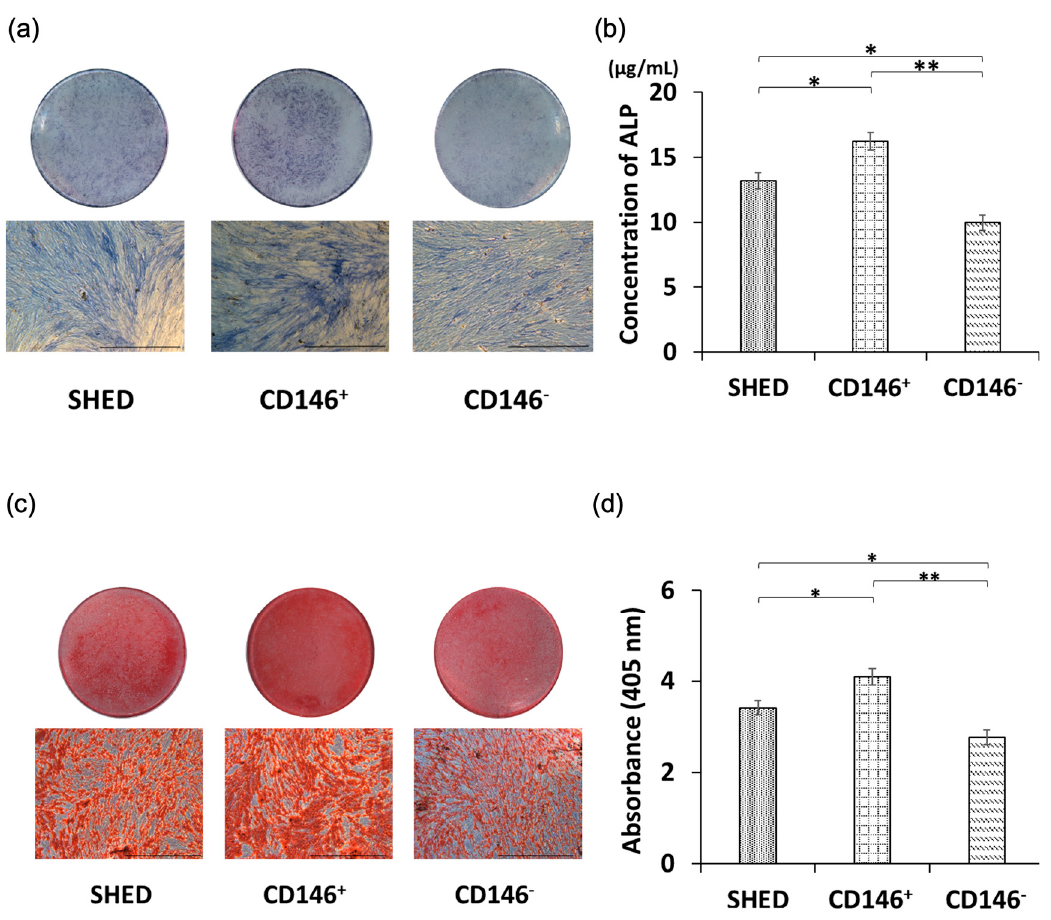
Figure 3. Osteogenic differentiation potential of SHED, CD146 + SHED, and CD146-SHED. ( a ) Osteogenic differentiation assessed by ALP staining on day 21. ALP staining was confirmed in all cells. The ALP staining intensity decreased in the following order: CD146 + SHED, SHED, and CD146- SHED (Scale bar = 500 μ m). ( b ) Determination of ALP protein levels by ELISA. ALP protein levels were significantly higher in CD146 + SHED than those in SHED and CD146-SHED. The same was true for SHED compared to CD146-SHED ( n = 5, Kruskal–Wallis method, ** p < 0.01, * p < 0.05). ( c ) Induced osteogenic differentiation. Osteogenic differentiation assessed by Alizarin red staining on day 28 decreased in the following order: CD146 + SHED, SHED, and CD146-SHED (Scale bar = 500 μ m). ( d ) CD146 + SHED showed significantly higher absorbance values than SHED and CD146- SHED ( n = 5, Kruskal–Wallis method, ** p < 0.01, * p < 0.05).